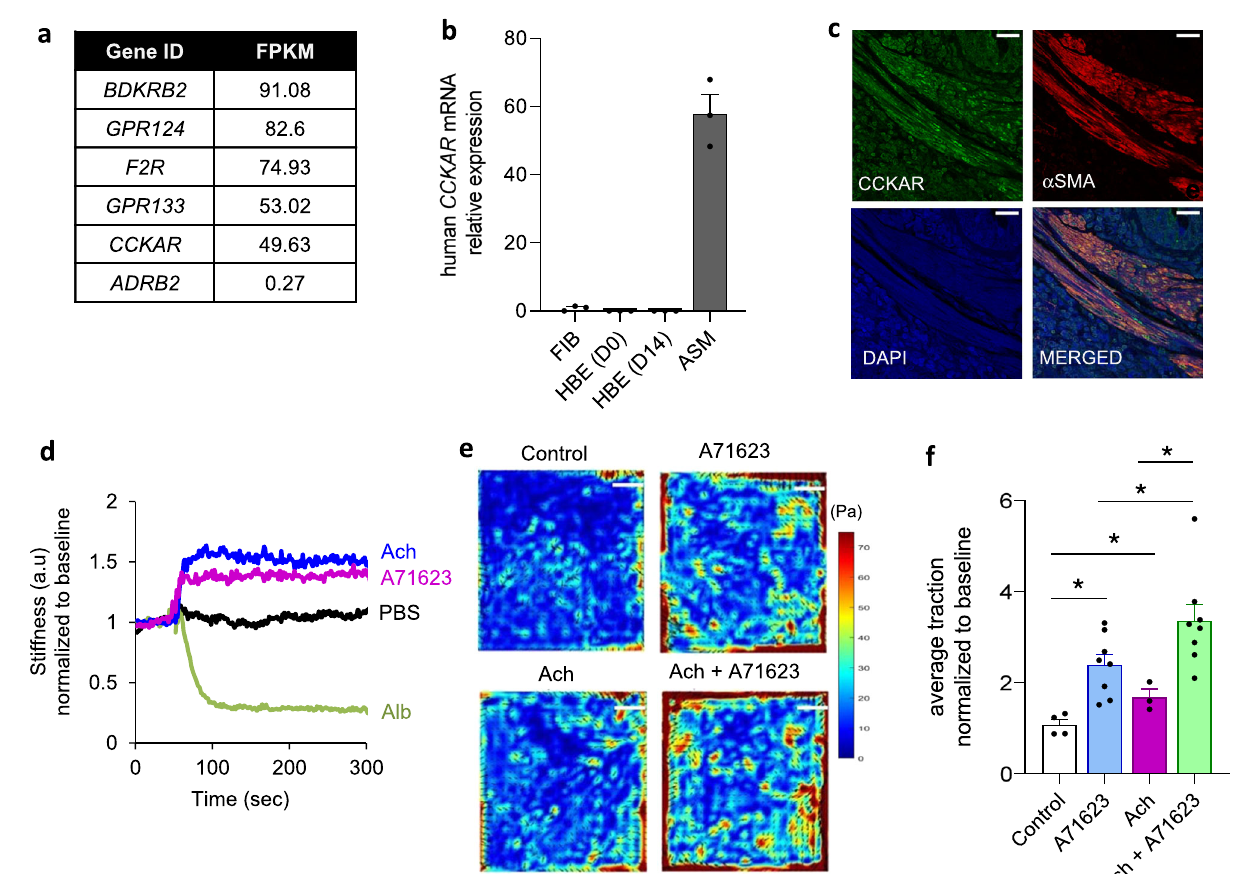
Fig.1|ASMcellsexpressCCKARandcontractinresponsetoCCKagonist.a List of the top non-olfactory GPCRs expressed in ASM cells. b qRT measurement of CCKAR mRNA expression in different airways cell types. FIB: primary lung fi bro- blasts; HBE: human bronchial epithelial (HBE) cells: HBE(D0) day 0 of initiation of air-liquid interface (ALI) culture; HBE(D14): day 14 post-ALI; ASM: airway